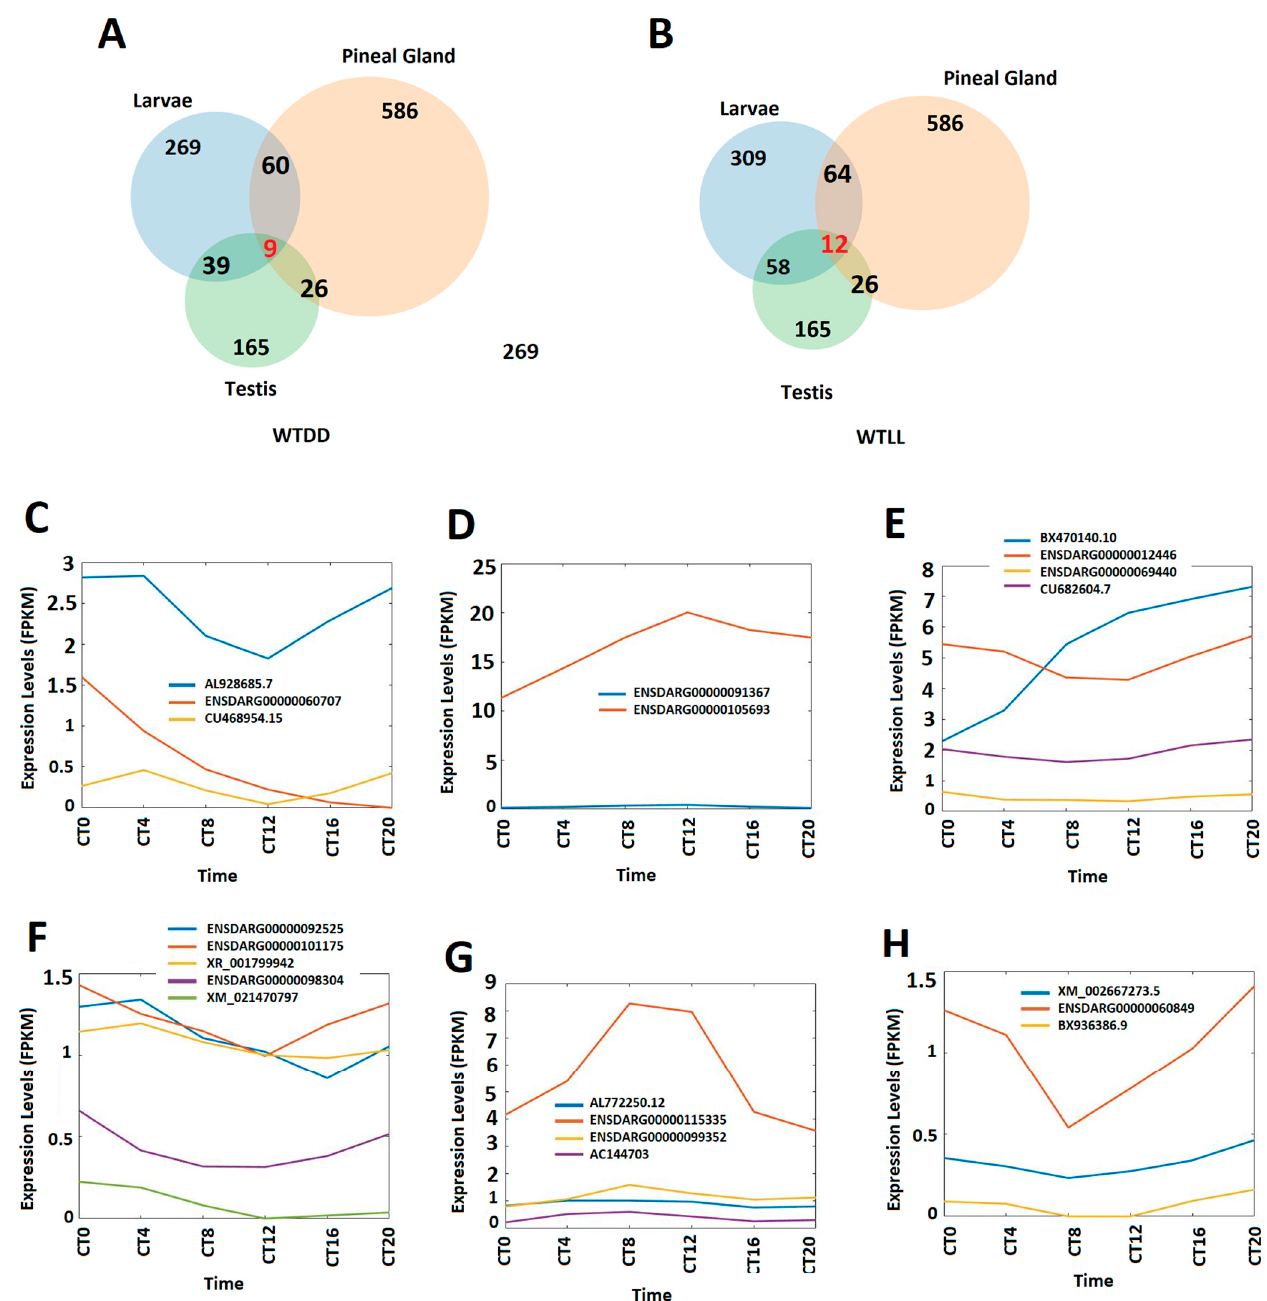
Figure 7. Circadianly expressed zebrafish larval lncRNAs are coexpressed in the zebrafish pineal gland and testis. ( A ) Circadianly expressed lncRNAs coexpressed in larvae, pineal gland and testis under DD condition. ( B ) Circadianly expressed lncRNAs coexpressed in larvae, pineal gland and testis under LL condition. ( C – E ) Expression profiles of representative lncRNAs under DD condition: three zebrafish larval morning (CT0 and CT 4) lncRNAs ( C ), two zebrafish larval evening (CT8 and CT12) lncRNAs ( D ), and four zebrafish larval night (CT16 and CT20) lncRNAs ( E ). ( F – H ) Expression profiles of representative lncRNAs under LL condition: five zebrafish larval morning lncRNAs ( F ), four zebrafish larval evening lncRNAs ( G ), and three zebrafish larval night lncRNAs ( H ).